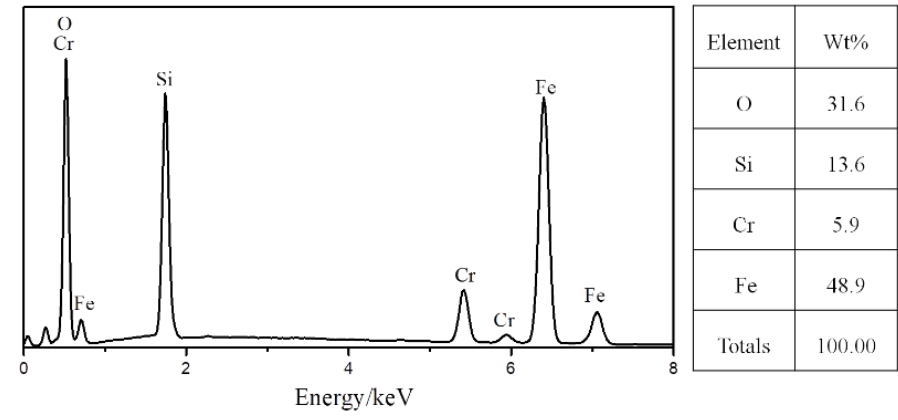
Figure 8. EDS analysis of the dark area (the point in Figure 7h).